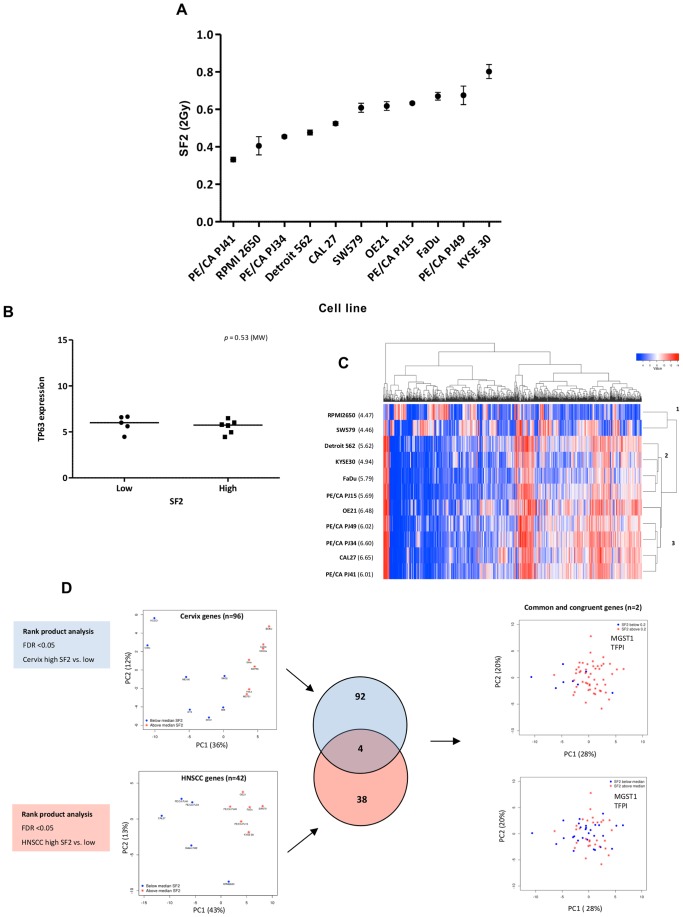
Characterisation of a head and neck squamous cell carcinoma (HNSCC) cell line cohort.
A) Graph showing the mean SF2 (log10) (y-axis) for each of the 11 cervix cancer cell lines (x-axis). Error bars show the standard error of mean of 2–3 independent experiments. B) Graph showing that there is no difference in TP63 expression between the SF2 high and low groups. Bar shows the median expression. C) Unsupervised hierarchical clustering of the top 1000 genes ranked by coefficient of variation (from U133 array data). Heatmap colouring is by log2 expression value. Rows represent genes and columns are cell lines. x-axis dendrogram (clusters) indicates the similarity of the cell lines and y-axis dendrogram the similarity of genes. Cluster 1 represents two samples with the lowest TP63 values (p63 negative). Cluster 2 shows the grouping of the other p63− cell line, along with low TP63 expressing lines. Cluster 3 groups together all HNSCC lines with >6.0 (log2 expression) TP63 expression. D) Diagram to represent the integrated SF2 analysis of the cervix and HNSCC cell lines. Rank product analysis (FDR <0.05) identified 96 genes in the cervix cohort differentially expressed between SF2 low and high cell lines. An identical analysis in the HNSCC cell lines identifies 97 probesets (42 genes) differentially expressed between SF2 low and high cell lines. PCA of the cervix genes shows that they are capable of separating the cell lines by SF2. PCA of the HNSCC genes is equally capable of separating the samples based on SF2. The Venn diagram shows that only 4/138 genes are common between the two cohorts and of these only 2/138 are “congruent” and associated with the same directionality (high SF2/low SF2 in both HNSCC and cervix). PCA shows probeset expression of these two “common” and “congruent” genes (MGST1 and TFPI) in the NCI-60 dataset. The NCI-60 upper PCA shows data-points coloured for median SF2 and lower PCA coloured for 0.2, used previously to partition radiosensitive and radioresistant cell lines in this cohort.